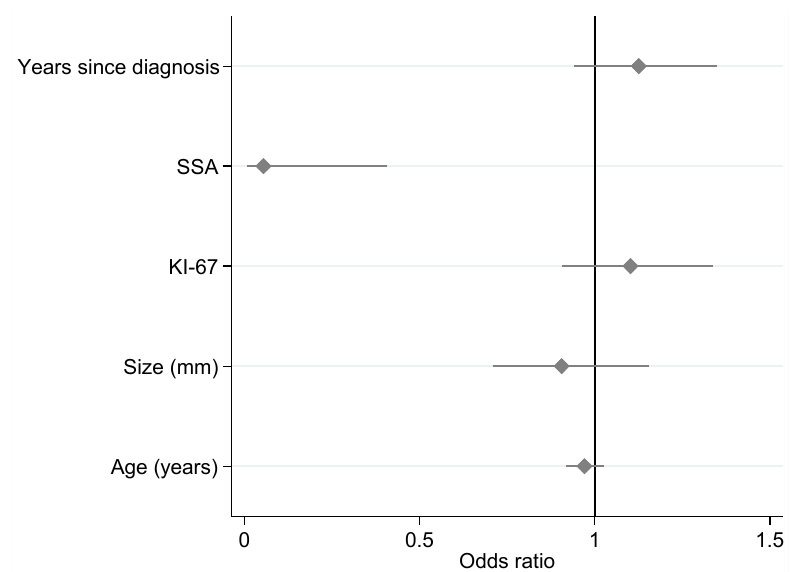
Figure 3. Treatment with somatostatin analogues is shown to be the only independent factor in preventing recurrence of GC-1. (Odds Ratio 0.054; p = 0.005). SSA: Somatostatin analogues.